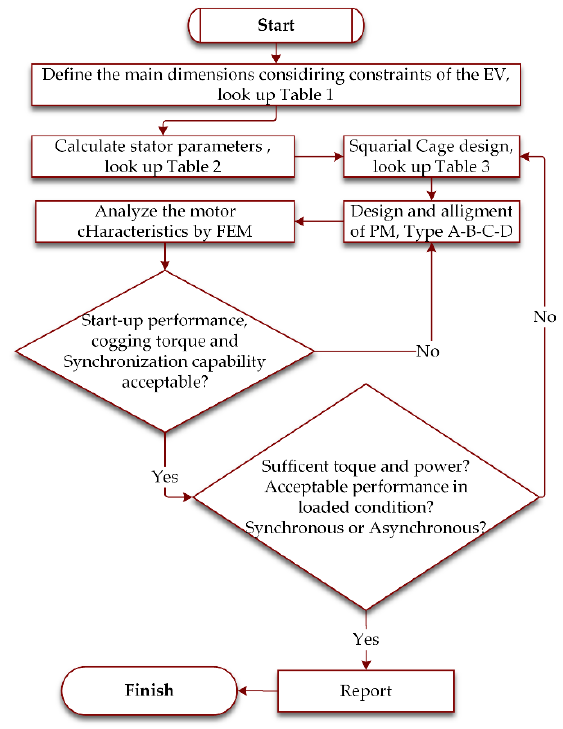
Figure 1. Design procedure of an OR-LSSM.